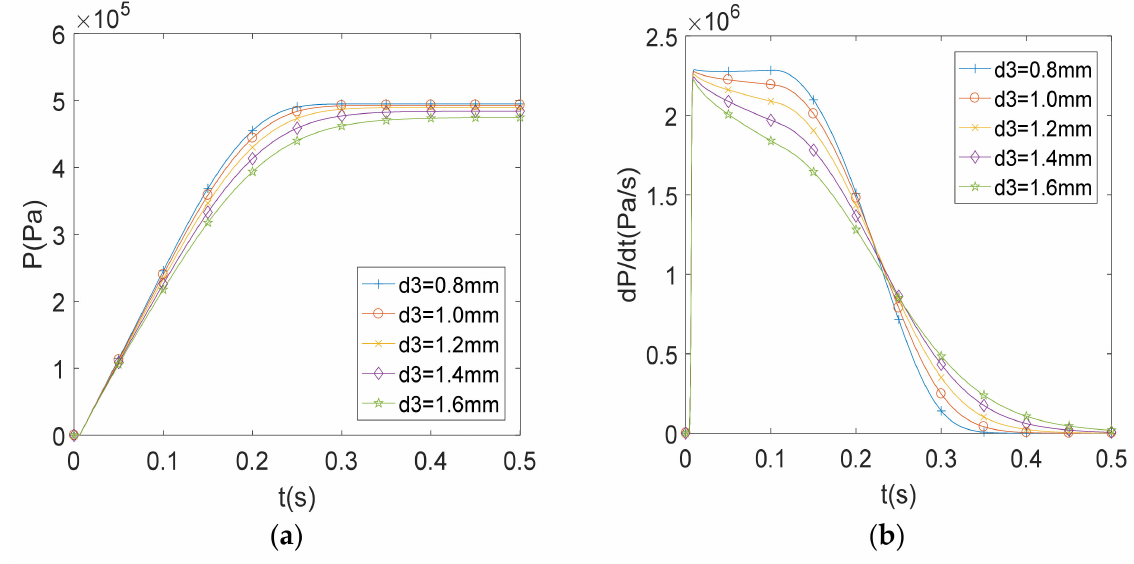
Figure 12. Influence of the diameter of exhaust port on pressure change rate: ( a ) pressure response; ( b ) pressure change rate